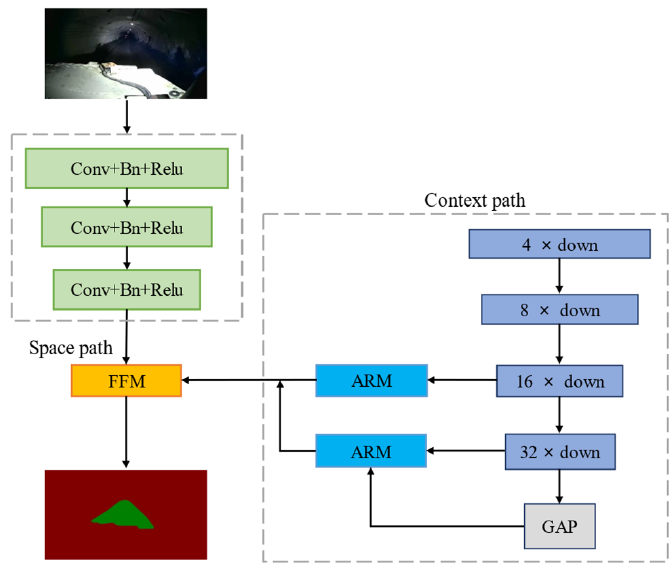
Figure 2. BiSeNet network.